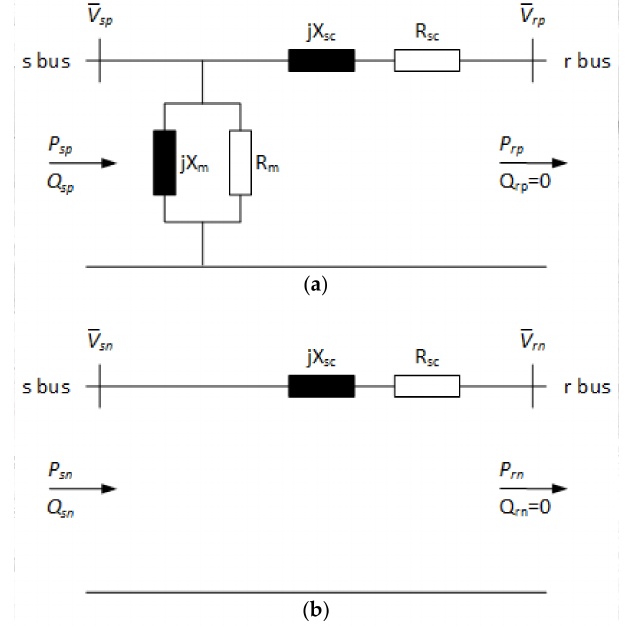
Figure 1. ( a ) positive-sequence and ( b ) negative sequence equivalent circuits of an induction generator referred to its stator